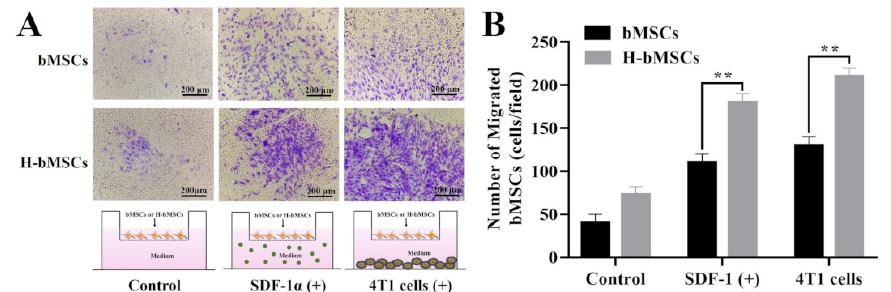
Figure 5. Evaluation of H-bMSCs migration in vitro. Images of the migrated bMSCs or H-bMSCs (in purple) through a membrane with 8 µ m pore size preformed in transwell ( A ); quantitative analysis of the in vitro migration of bMSCs or H-bMSCs ( B ). (** p <